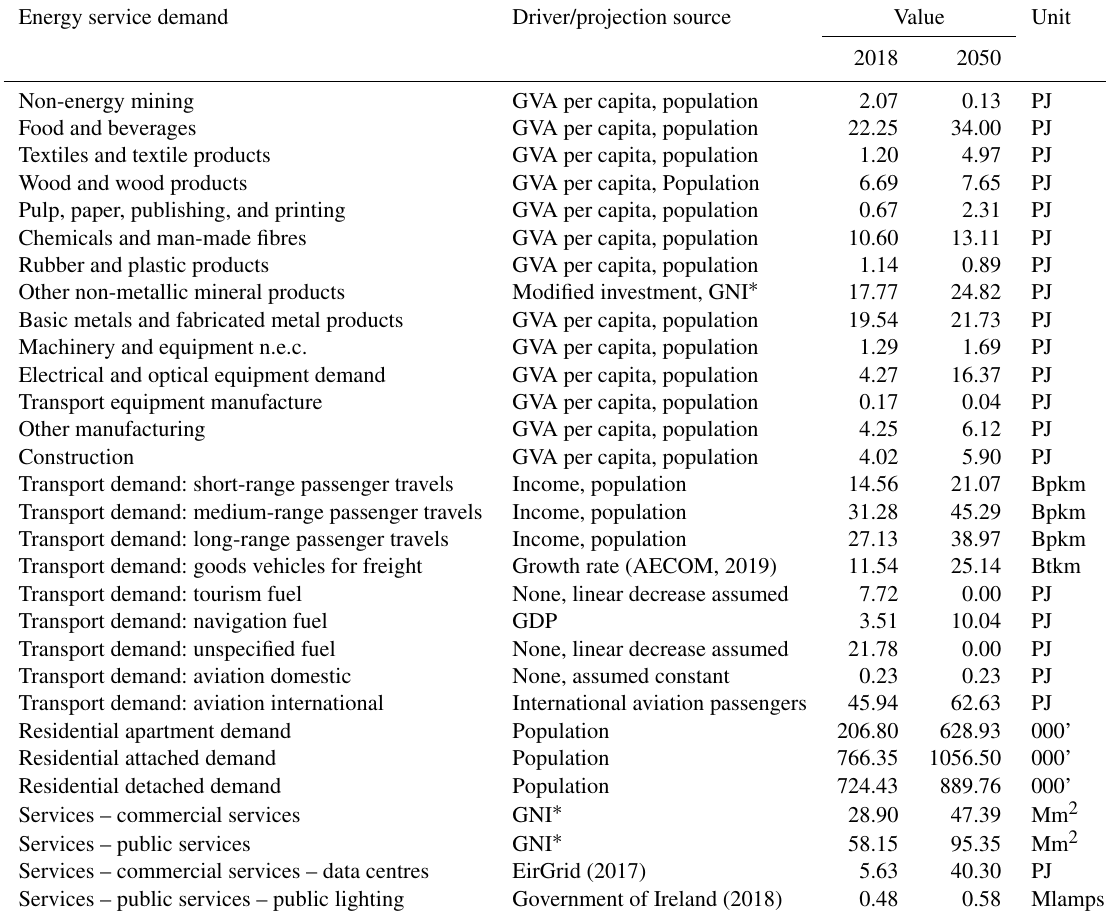
Table 2. Energy service demands in